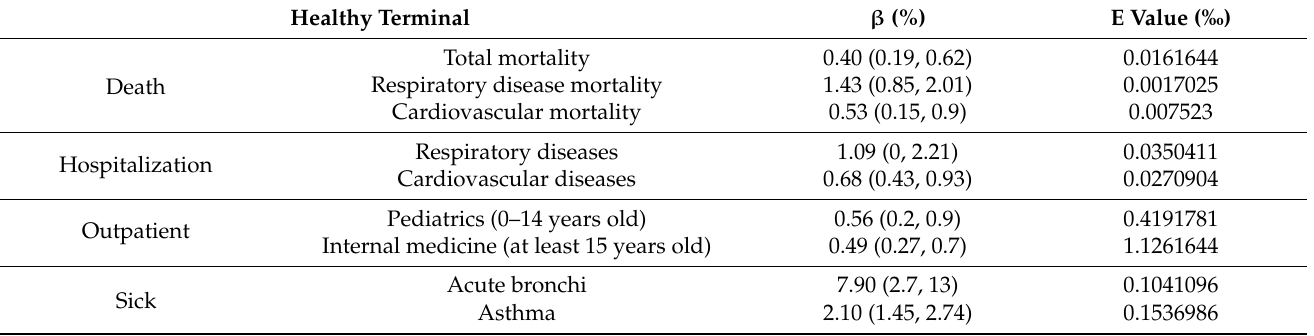
Table 2. The coefficients of the PM 2.5 exposure-response relationship and the baseline incidence at different health